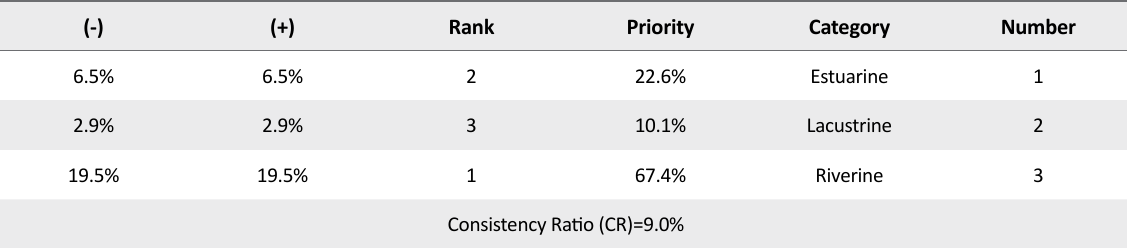
Table 1. Weight of coastal strip physical classification